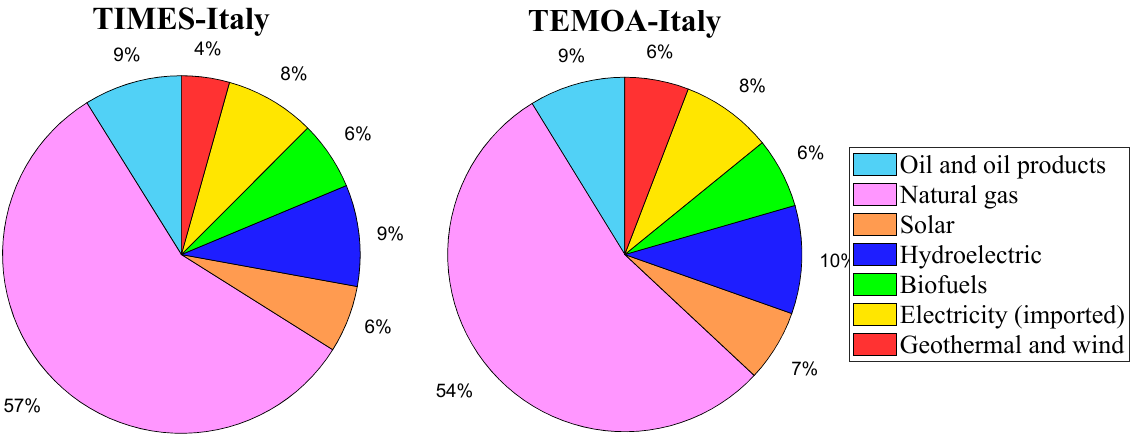
Figure 5. Comparison of the optimal energy mixes for electricity production in 2030.